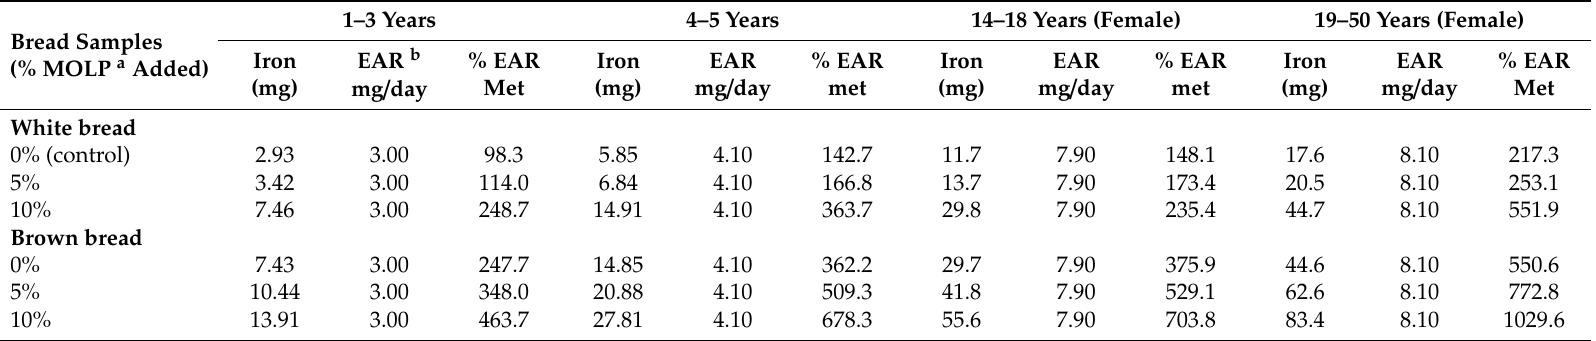
Table 5. Percentage of the estimated average requirement met for iron for vulnerable population groups using the estimated portions of bread. Bread Samples